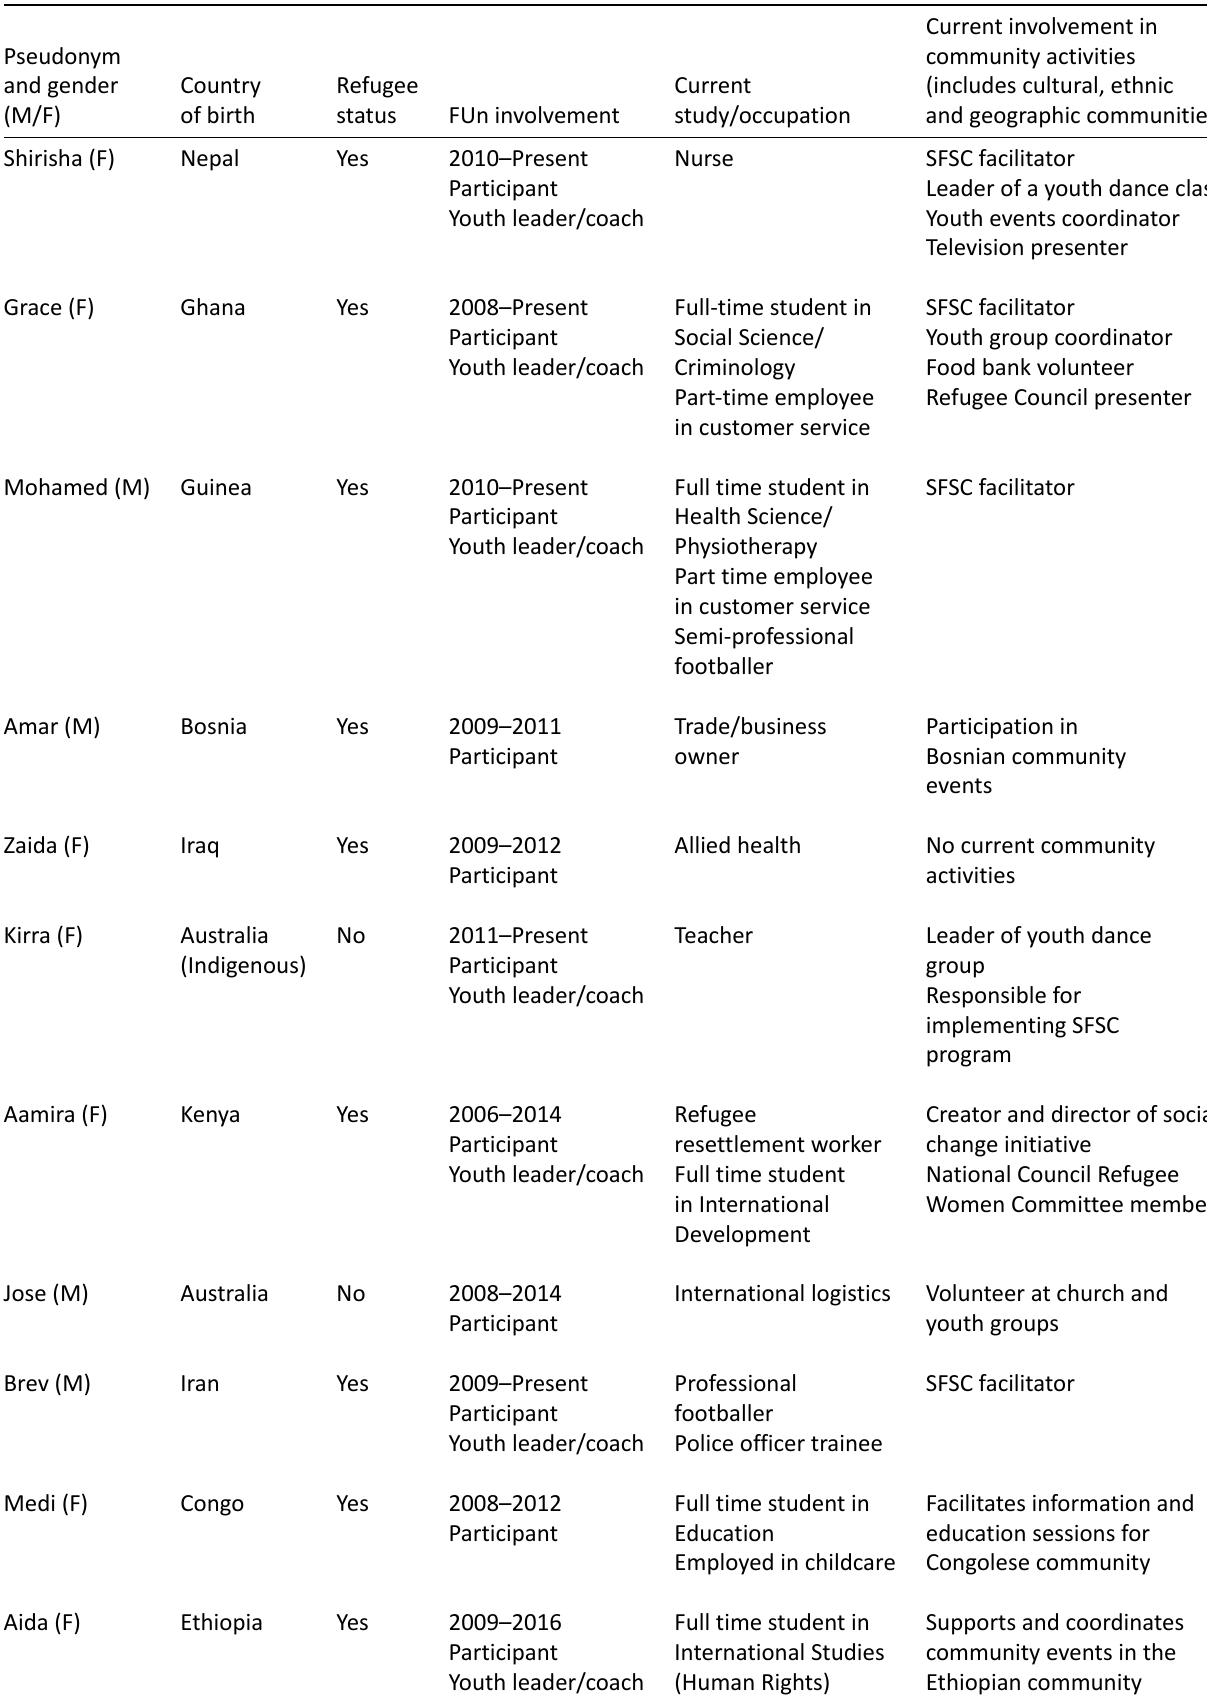
Table 1. Participant characteristics and